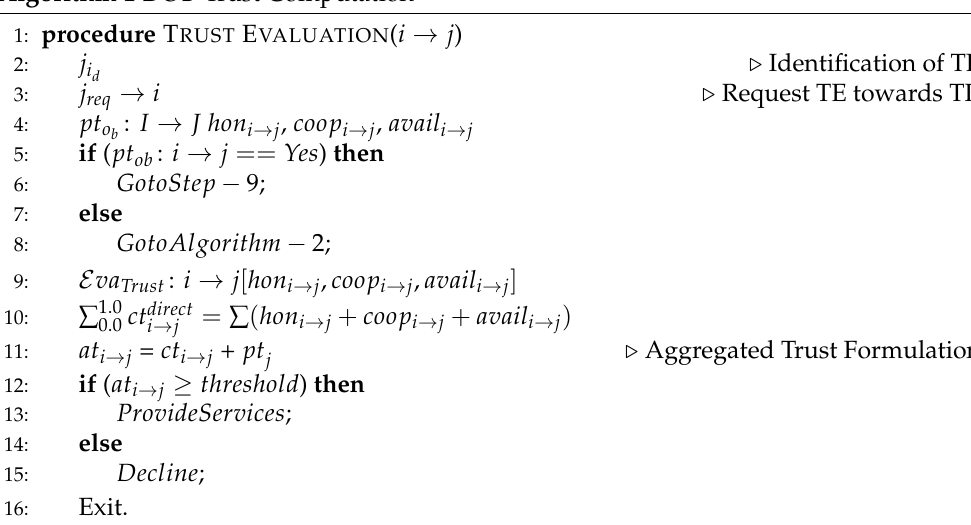
Algorithm 1 DOB-Trust